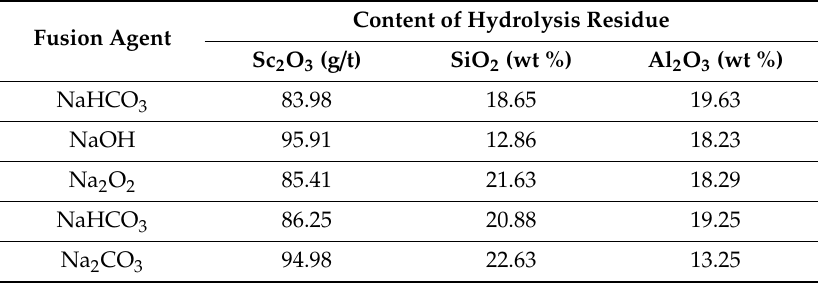
Table 3. E ff ect results of di ff erent fusion agent on removal of silica and